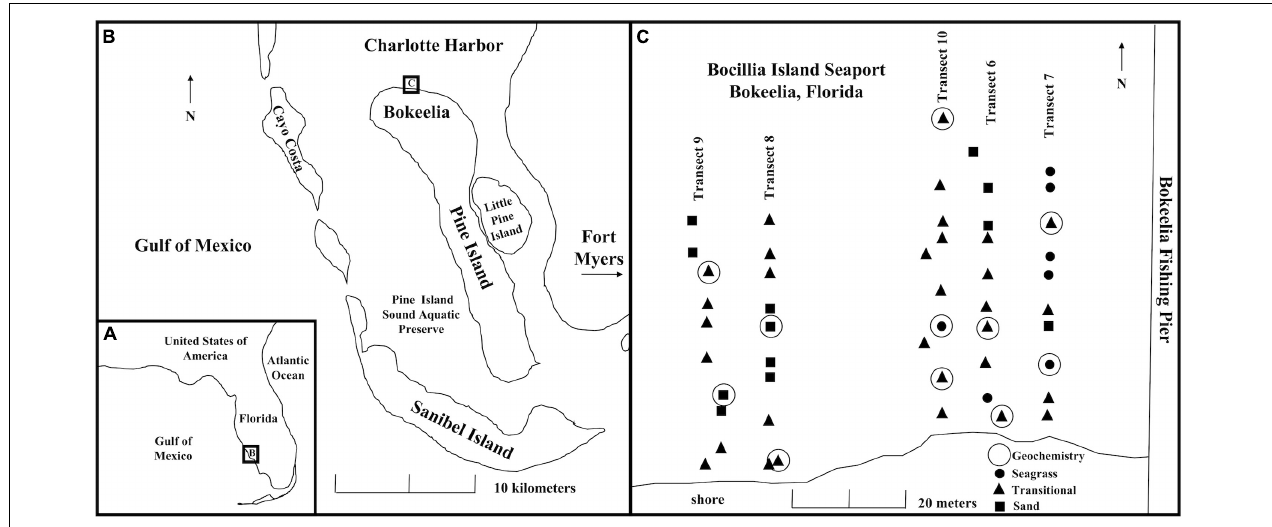
FIGURE 1 | (A) Regional map showing the location of Pine Island relative to Florida. (B) Location of study site on Pine Island indicated by a box labeled with a C. (C) Map of transects and sampled sites in Bokeelia, with symbols reflecting multiyear seagrass stability categories described in Supplementary Table 1 (sand = no seagrass cover; seagrass = complete seagrass cover; transitional = partial seagrass cover). Sites where porewater were collected for geochemistry are indicated by an open circle.